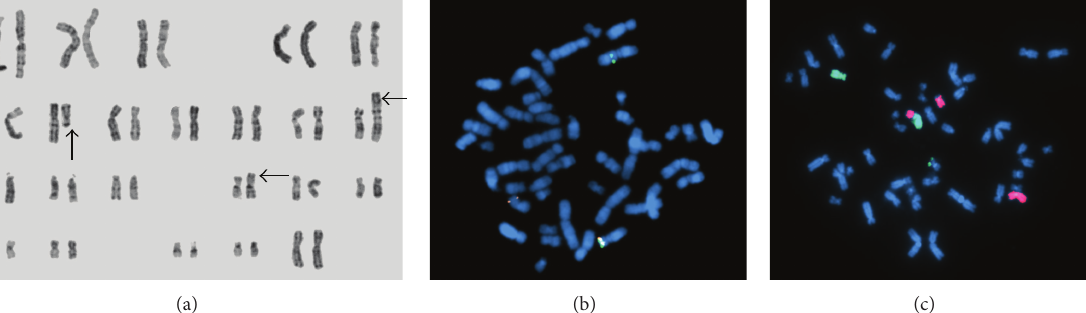
Figure 2: Cytogenetics of the patient’s bone marrow (a) G-banded karyotype showing 46,XX,t(7;12)(q22;p13),add(16)(p13); (b) fluorescence in situ hybridization using a dual-color break-apart probe showing rearrangement of ETV6 (12p13) (c) whole chromosome painting of chromosomes 7 (red) and 12 (green) showing 46,XX,